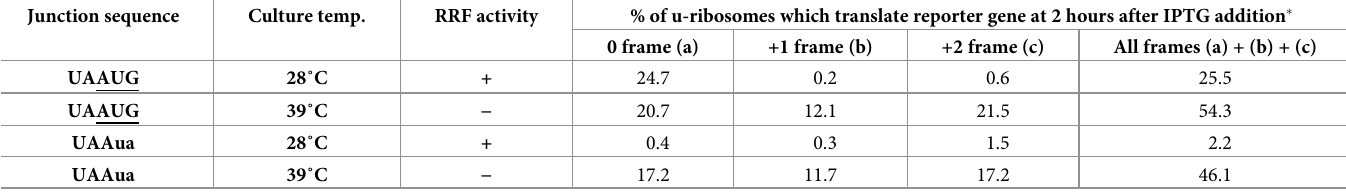
Table 1. Heat inactivation of RRF makes more u-ribosomes read downstream. Junction sequence Culture